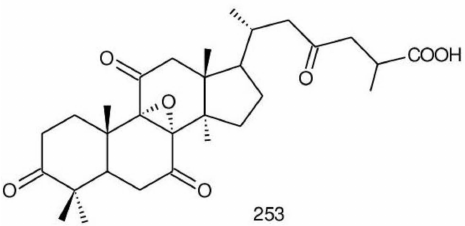
Figure 6. Chemical structure of 8 α ,9 α -epoxy-3,7,11,15,23-pentaoxo-5 α -lanosta-26-oic acid ( 253 ). 7(8),9(11)-diene-triterpenoids